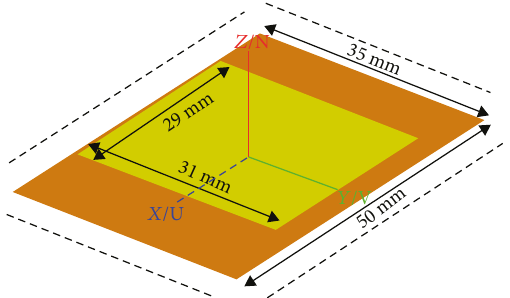
Figure 1: Patch antenna over a fi nite rectangular ground plane to analyze with CMA. Separation between the two plates is 1.524mm.